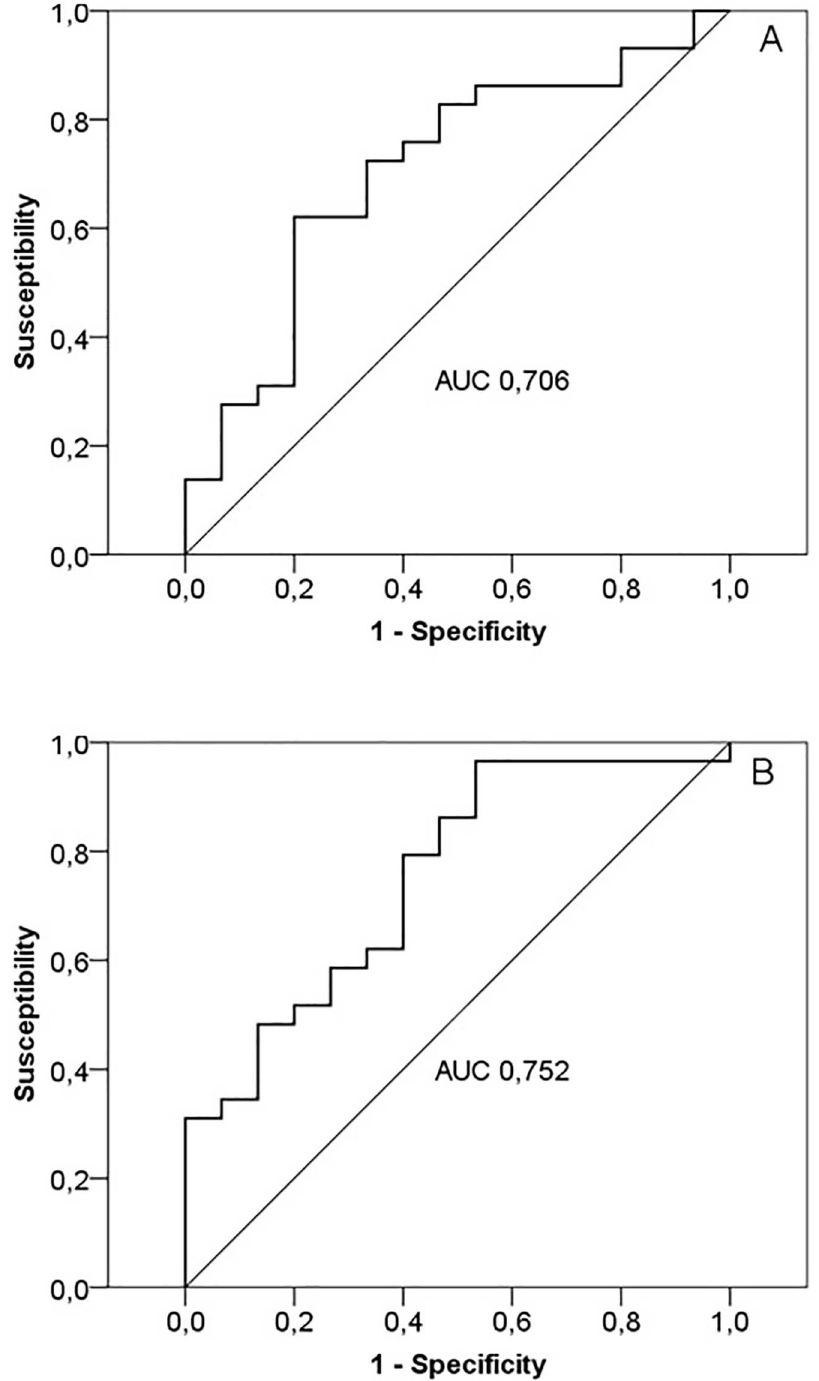
Fig 3. Receiver operatingcharacteristics (ROC) curves used to discriminate survivors compared to non- survivors with severe sepsis/septic shock based on percentageof changein serum levels of IL-6 (A) and procalcitonin (B) from day 0 to day 5 of ICU